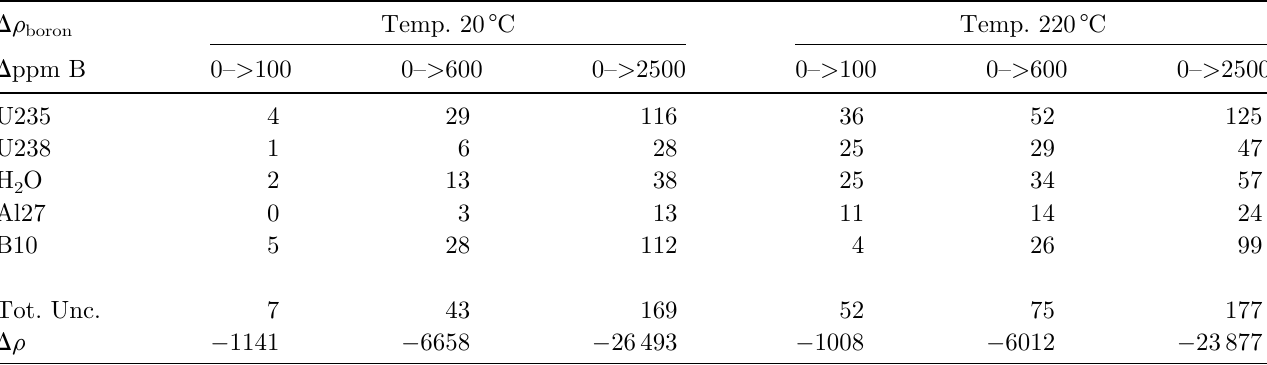
Table 4. Reactivity coef fi cients uncertainties, on the left, at 20 ° C, on the right at 220 ° C for boron amount variations (pcm at 1 s ). D r boron